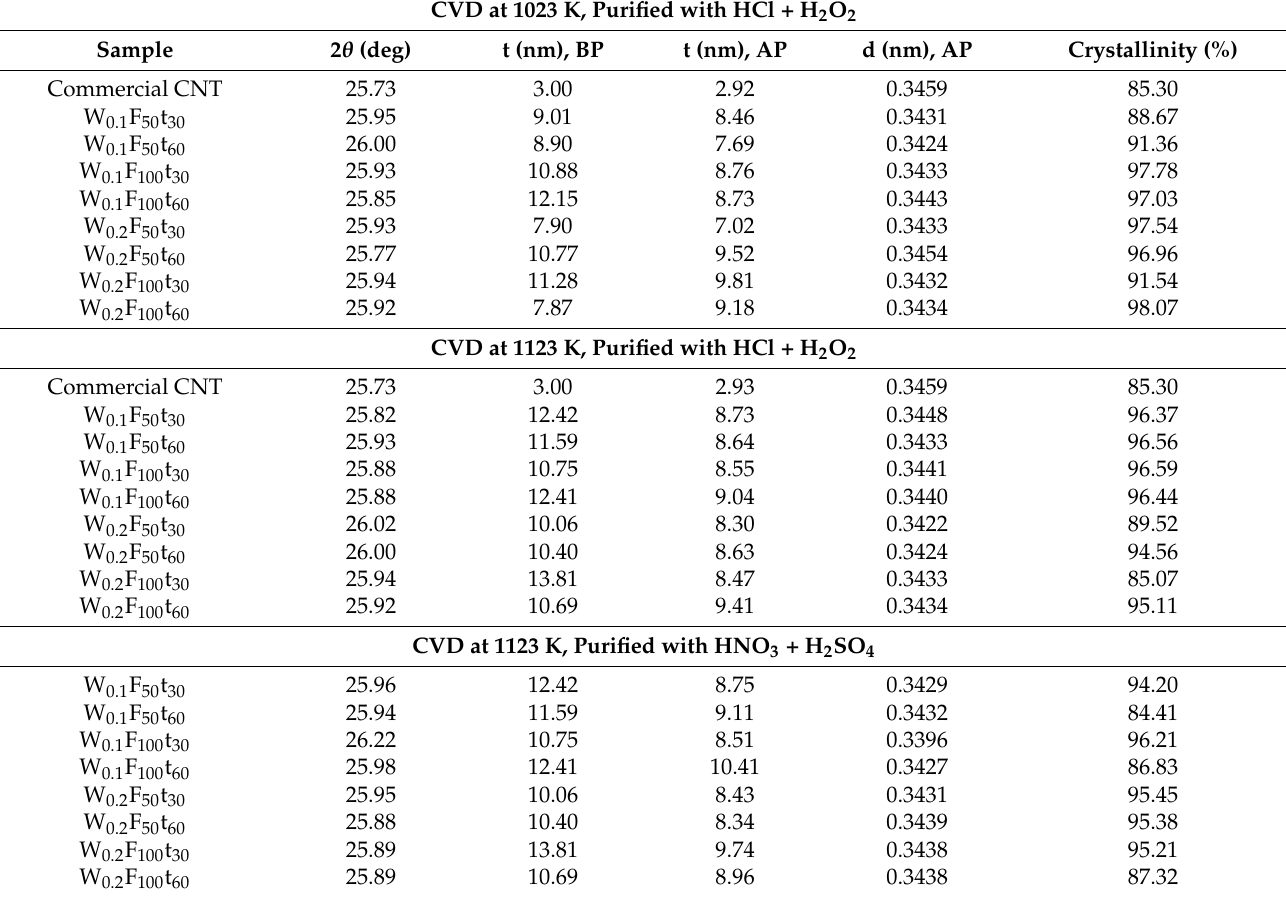
Table 1. Crystallite size and crystallinity percent for MWCNT synthesized at 1023 and 1123 K without and with purification. Samples at 1123 K were purified with two acid solutions (HCl + H 2 O 2 and HNO 3 + H 2 SO 4 ) to determinate the effect of the crystallite size, crystallinity percent, and